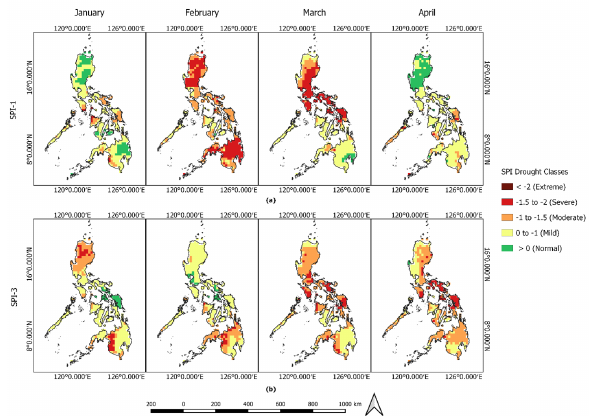
Figure 3. SPI at different timescales.